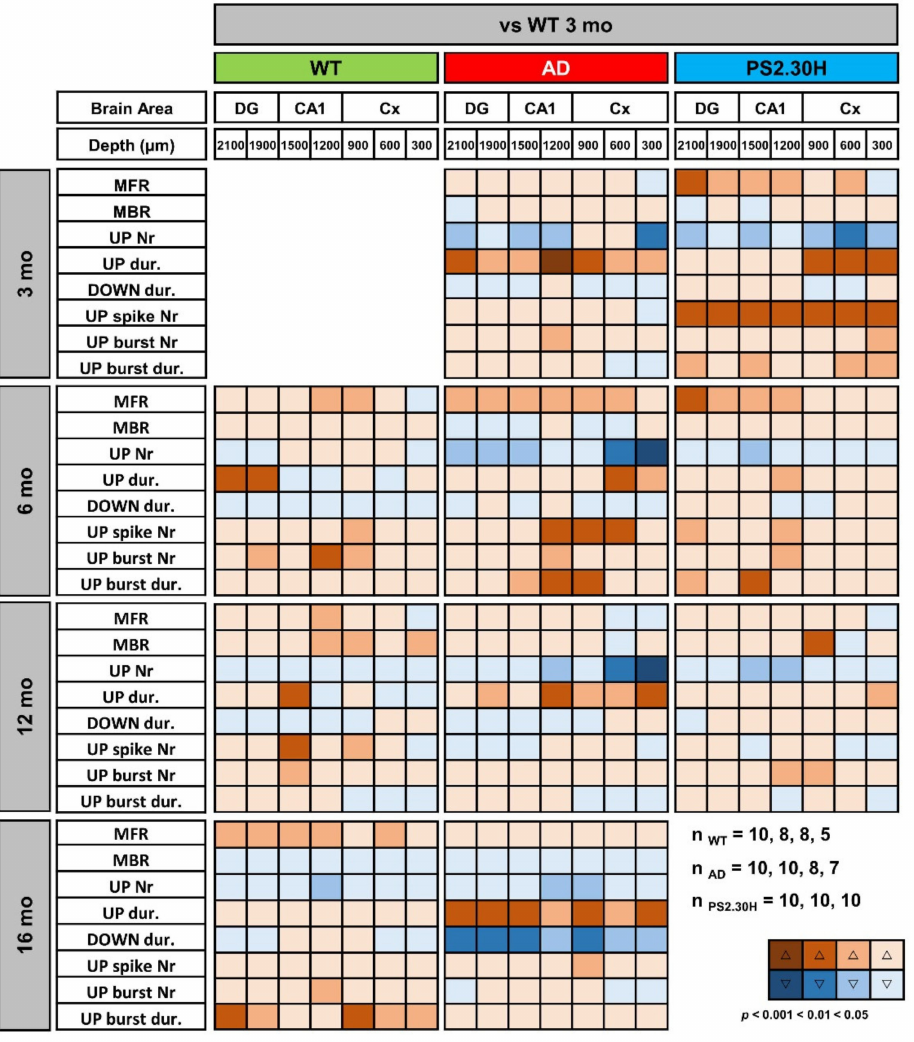
Figure 8. Alterations in UP-DOWN states and spiking activity are shared by mice expressing the mutant PS2. Synoptic views of cortical and hippocampal changes in UP-DOWN states and spiking activity of 3-, 6-, 12- and 16-month-old WT and AD mice, versus 3-month-old WT mice. The same parameters are presented also for the single transgenic PS2.30H mouse line, expressing only the mutant PS2-N141I. Warm and cold colors indicate increase and decrease, respectively. The color intensity reflects the level of statistical significance. With respect to previous analyses, few mice were discarded because of spike artifacts in the selected band region (0.3–3 kHz); n indicates the number of mice used for each genotype at 3, 6, 12 and 16 months of age; no mice were available for the16-month-old PS2.30H cohort. MFR, Mean Firing Rate; MBR, Mean Bursting